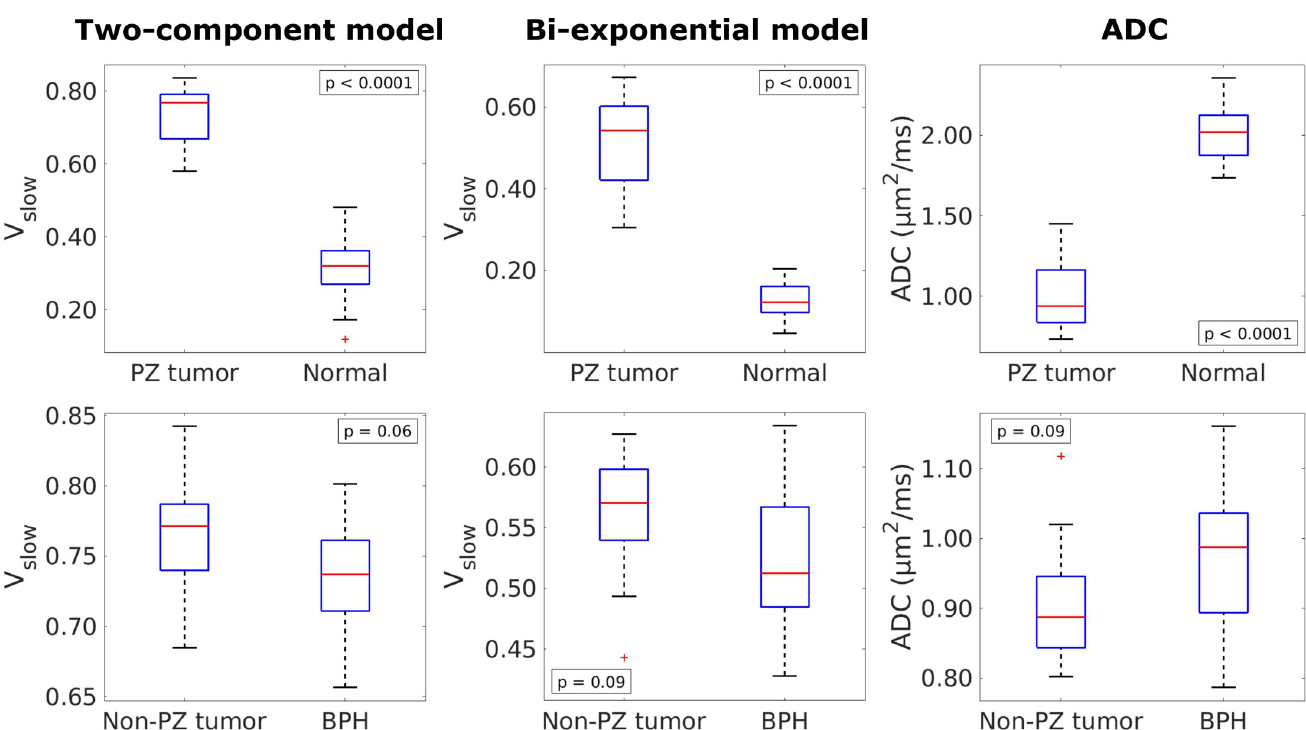
Fig 2. Box plots showing the distribution of mean SF slow (from the two-component and bi-exponential models) and ADC of the different ROIs. Upper row: PZ tumors (n = 24) compared to normal tissue (n = 24). Bottom row: Non-PZ tumors (n = 13) compared to BPH (n = 14). p < 0.006 was considered statistically